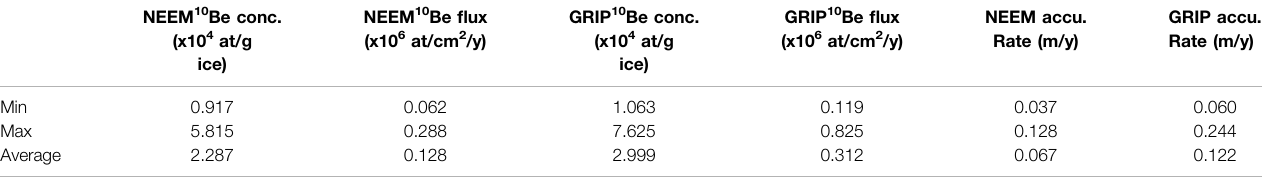
TABLE 1 | Summary data for the raw data ranges of 10 Be concentration and fl ux and snow accumulation rate in the NEEM and GRIP ice cores. NEEM 10 Be